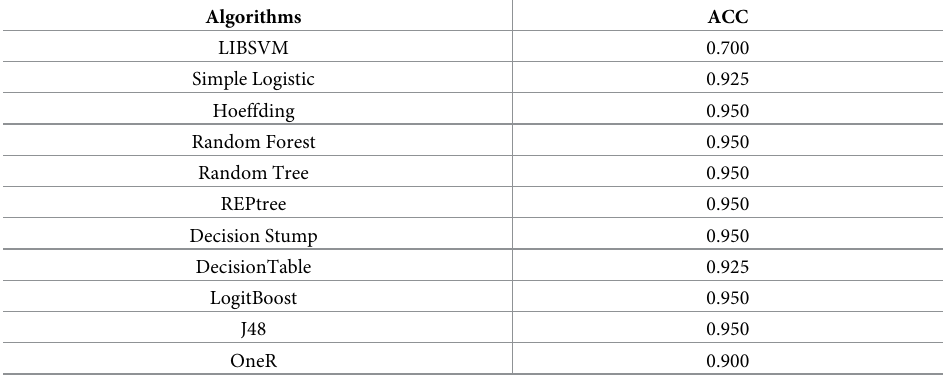
Table 6. The cross-validation results of each stage 2 classifier with each comparing learning algorithms.